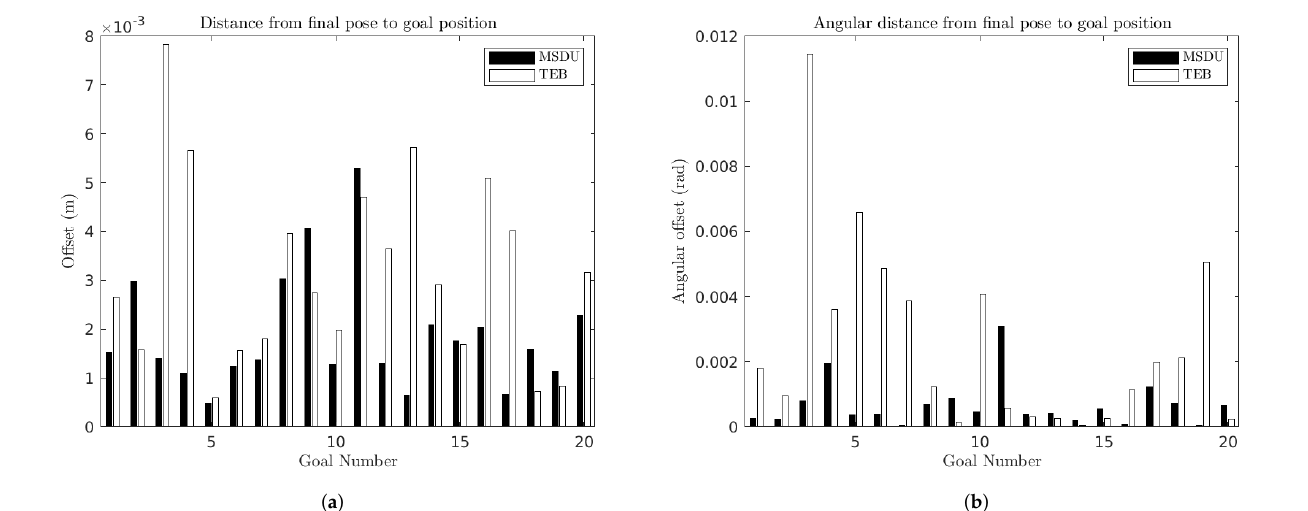
Figure 9. Distance between final robot pose and desired goal position for the MSDU Local Planner (black) and the TEB Local Planner (white) over long paths. ( a ) Translational error between the final robot pose and the desired goal position; ( b ) angular error between the final robot pose and the desired goal position.